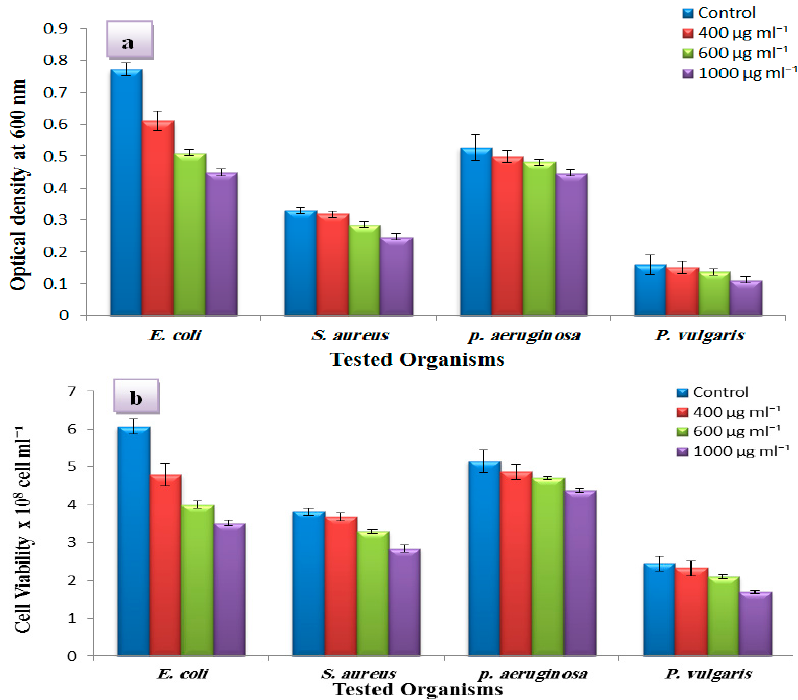
Figure 8. Growth curves of tested bacteria in the presence TiO 2 NPs: ( a ) optical density, ( b ) cell viability.